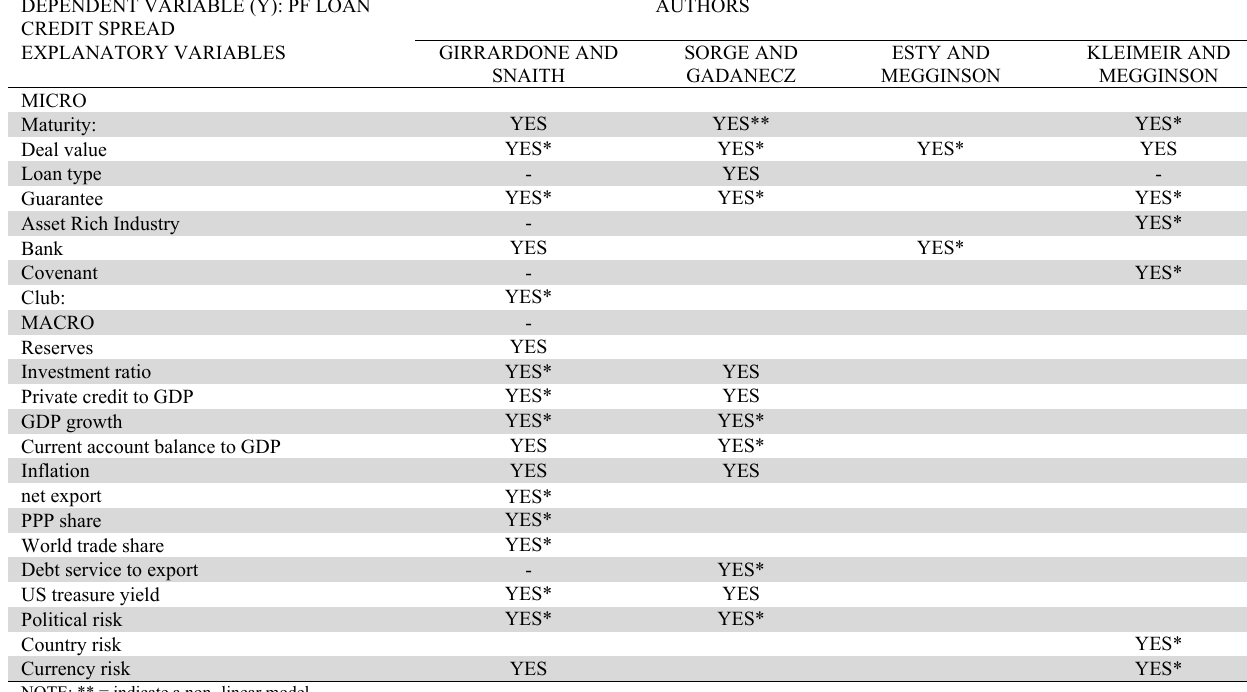
Overview of the literatures: explanatory variables